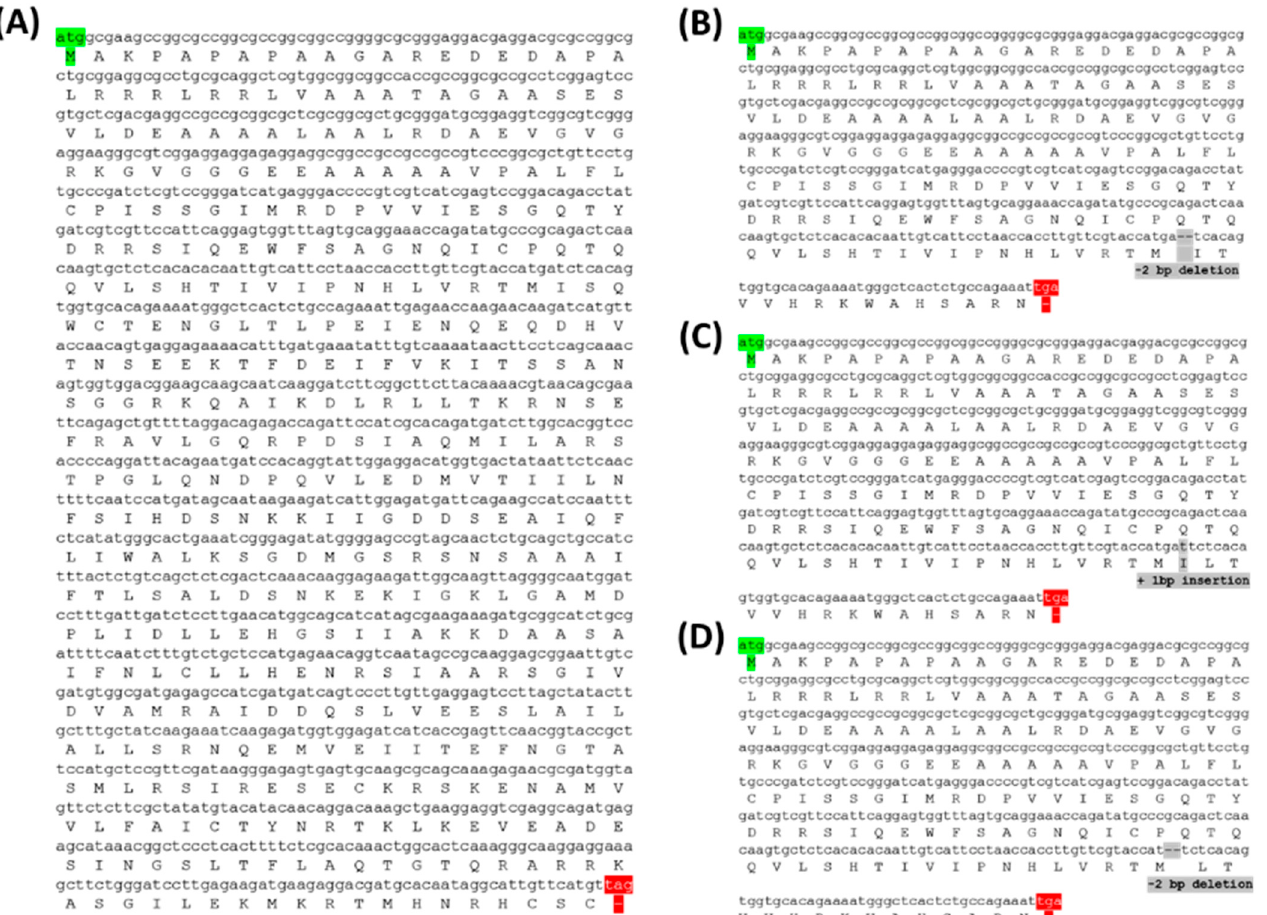
Figure 10. Amino acid sequence based on nucleotide sequence of PUB7-GE. Green indicates the start codon, red indicates the stop codon, and gray indicates the InDel mutation type. ( A ) OsPUB7 wild type. ( B ) PUB7-GE K343-7-5. ( C ) PUB7-GE K343-8-1. ( D ) PUB7-GE K343-17-8.